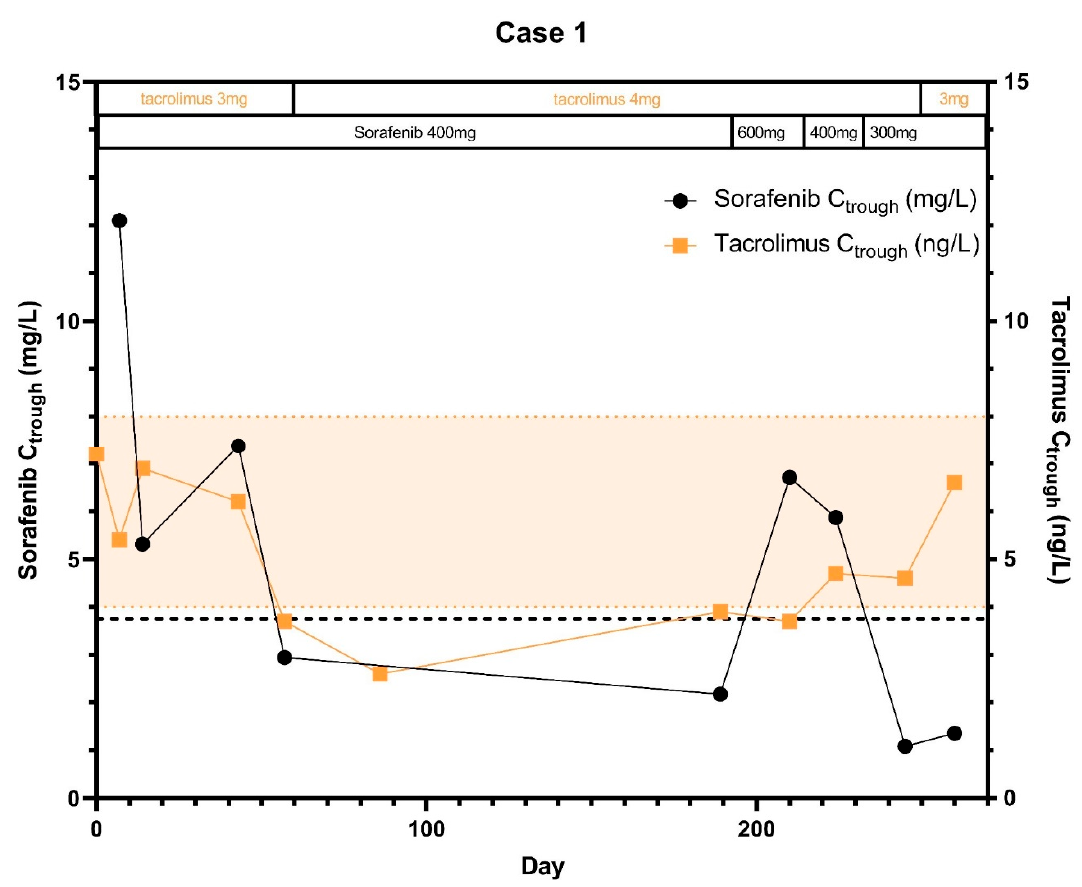
Figure 1. Sorafenib and tacrolimus C trough concentrations over time for Subject 1: The C trough levels are displayed over time after the start of sorafenib treatment. Furthermore the optimal C trough levels of both sorafenib and tacrolimus are provided.